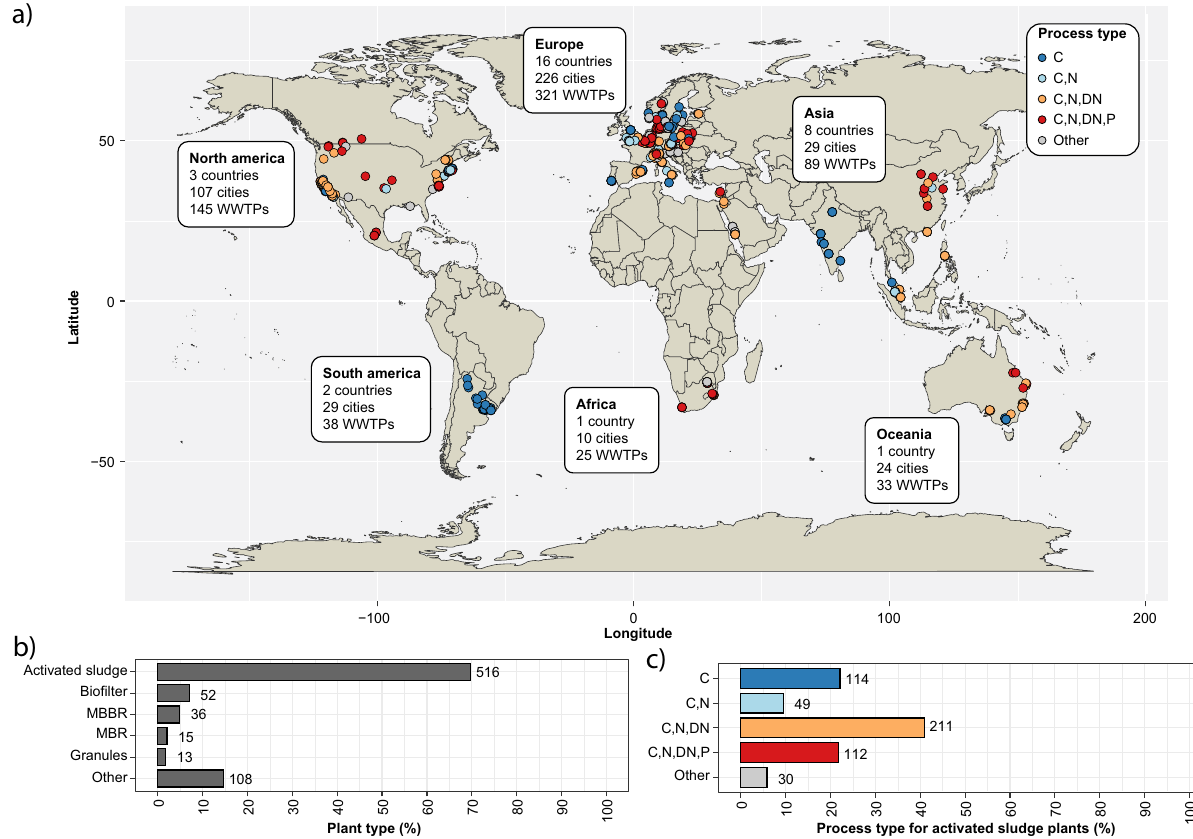
Fig. 1 Sampling of WWTPs across the world. a Geographical distribution of WWTPs included in the study and their process con fi guration. b Distribution of plant types. MBBR moving bed bioreactor, MBR membrane bioreactor. c Distribution of process types for the activated sludge plants. C carbon removal, C,N carbon removal with nitri fi cation, C,N,DN carbon removal with nitri fi cation and denitri fi cation, C,N,DN,P carbon removal with nitrogen removal and enhanced biological phosphorus removal (EBPR). The values next to the bars are the number of WWTPs in each group.